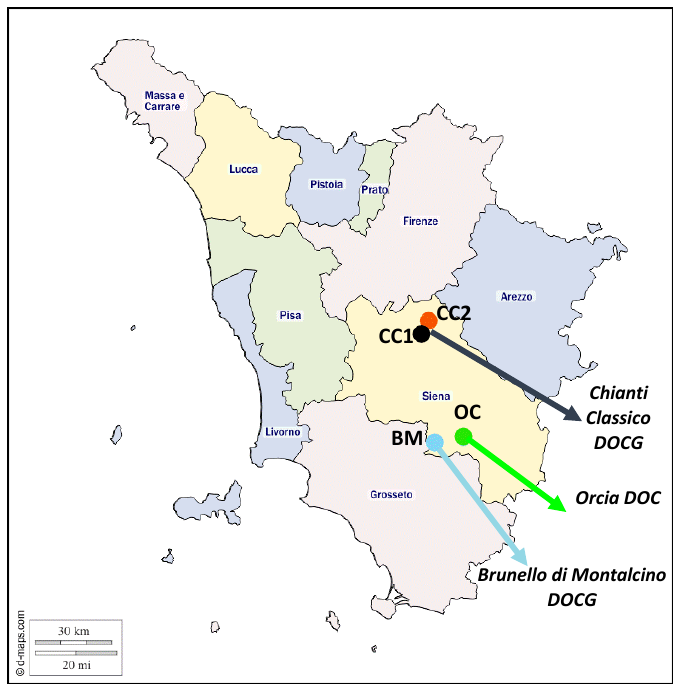
Figure 1. Location of the four wineries (BM, OC, CC1 and CC2) in the Tuscany region.